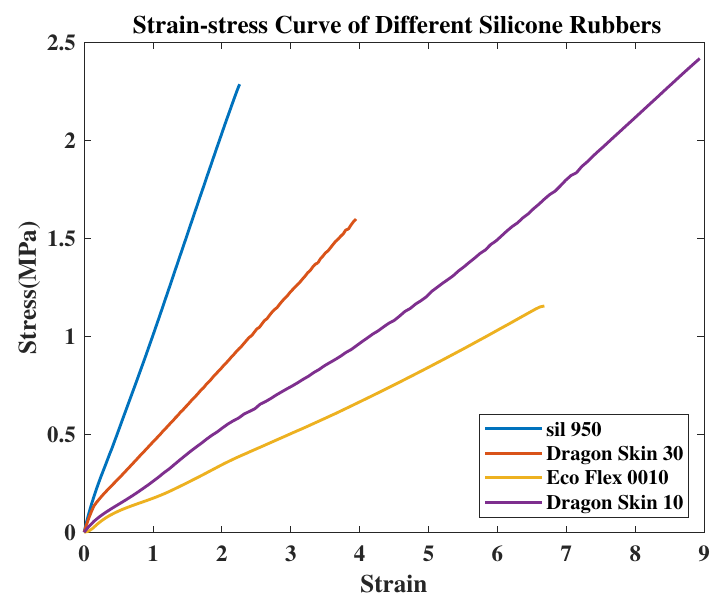
Figure 3. Strain-stress curve of four different silicone